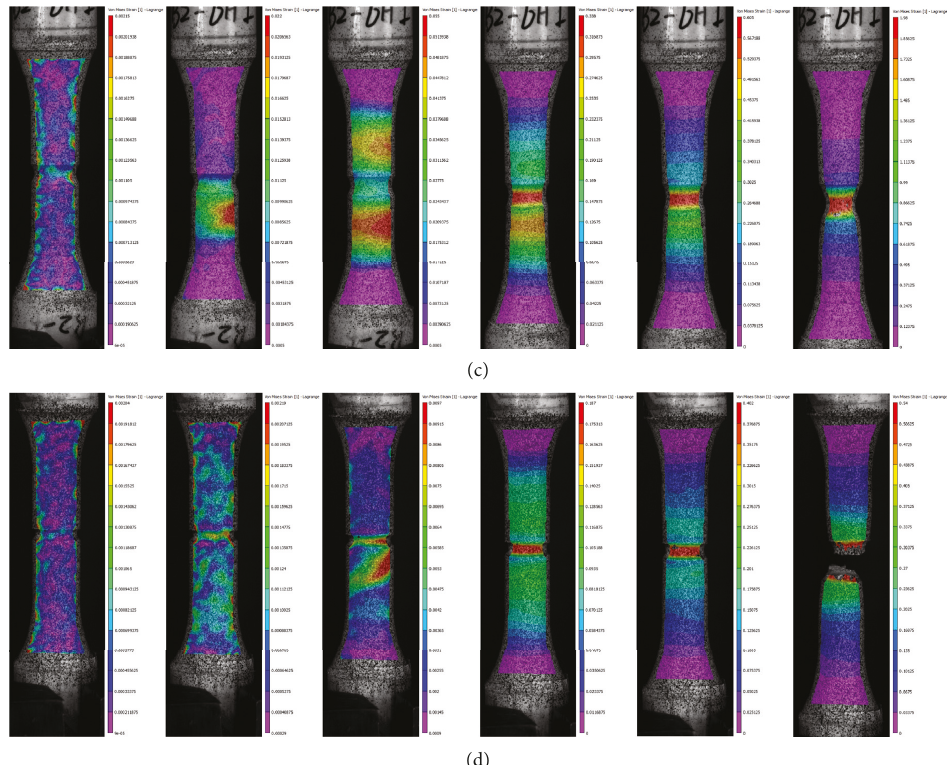
Figure 9: The stress nephogram distribution of HAZ specimens. (a) B-6-SH. (b) B-6-H. (c) B2-6-H. (d)